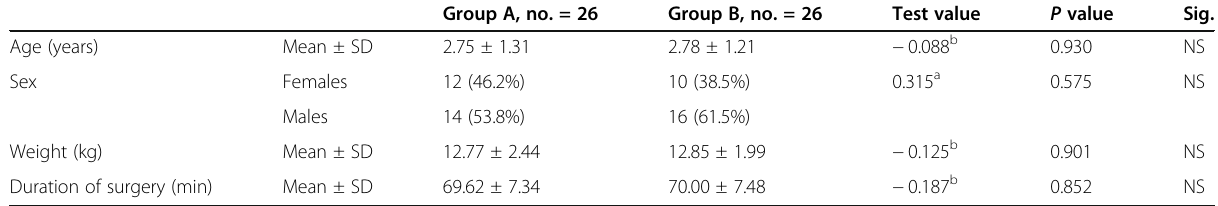
Table 2 Comparison between group A and group B regarding demographic data of the studied patients Group A, no. = 26